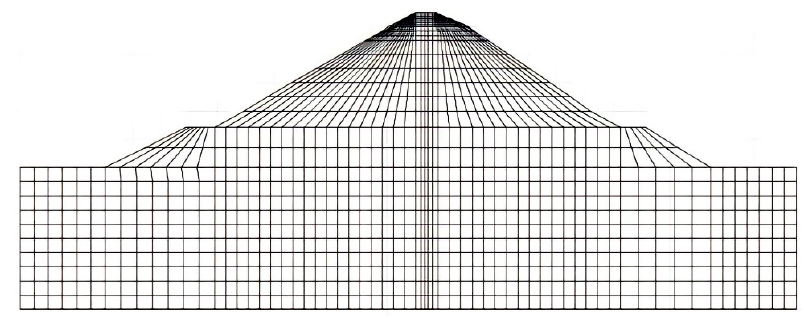
Figure 2. Grid generated for Meijaran dam.